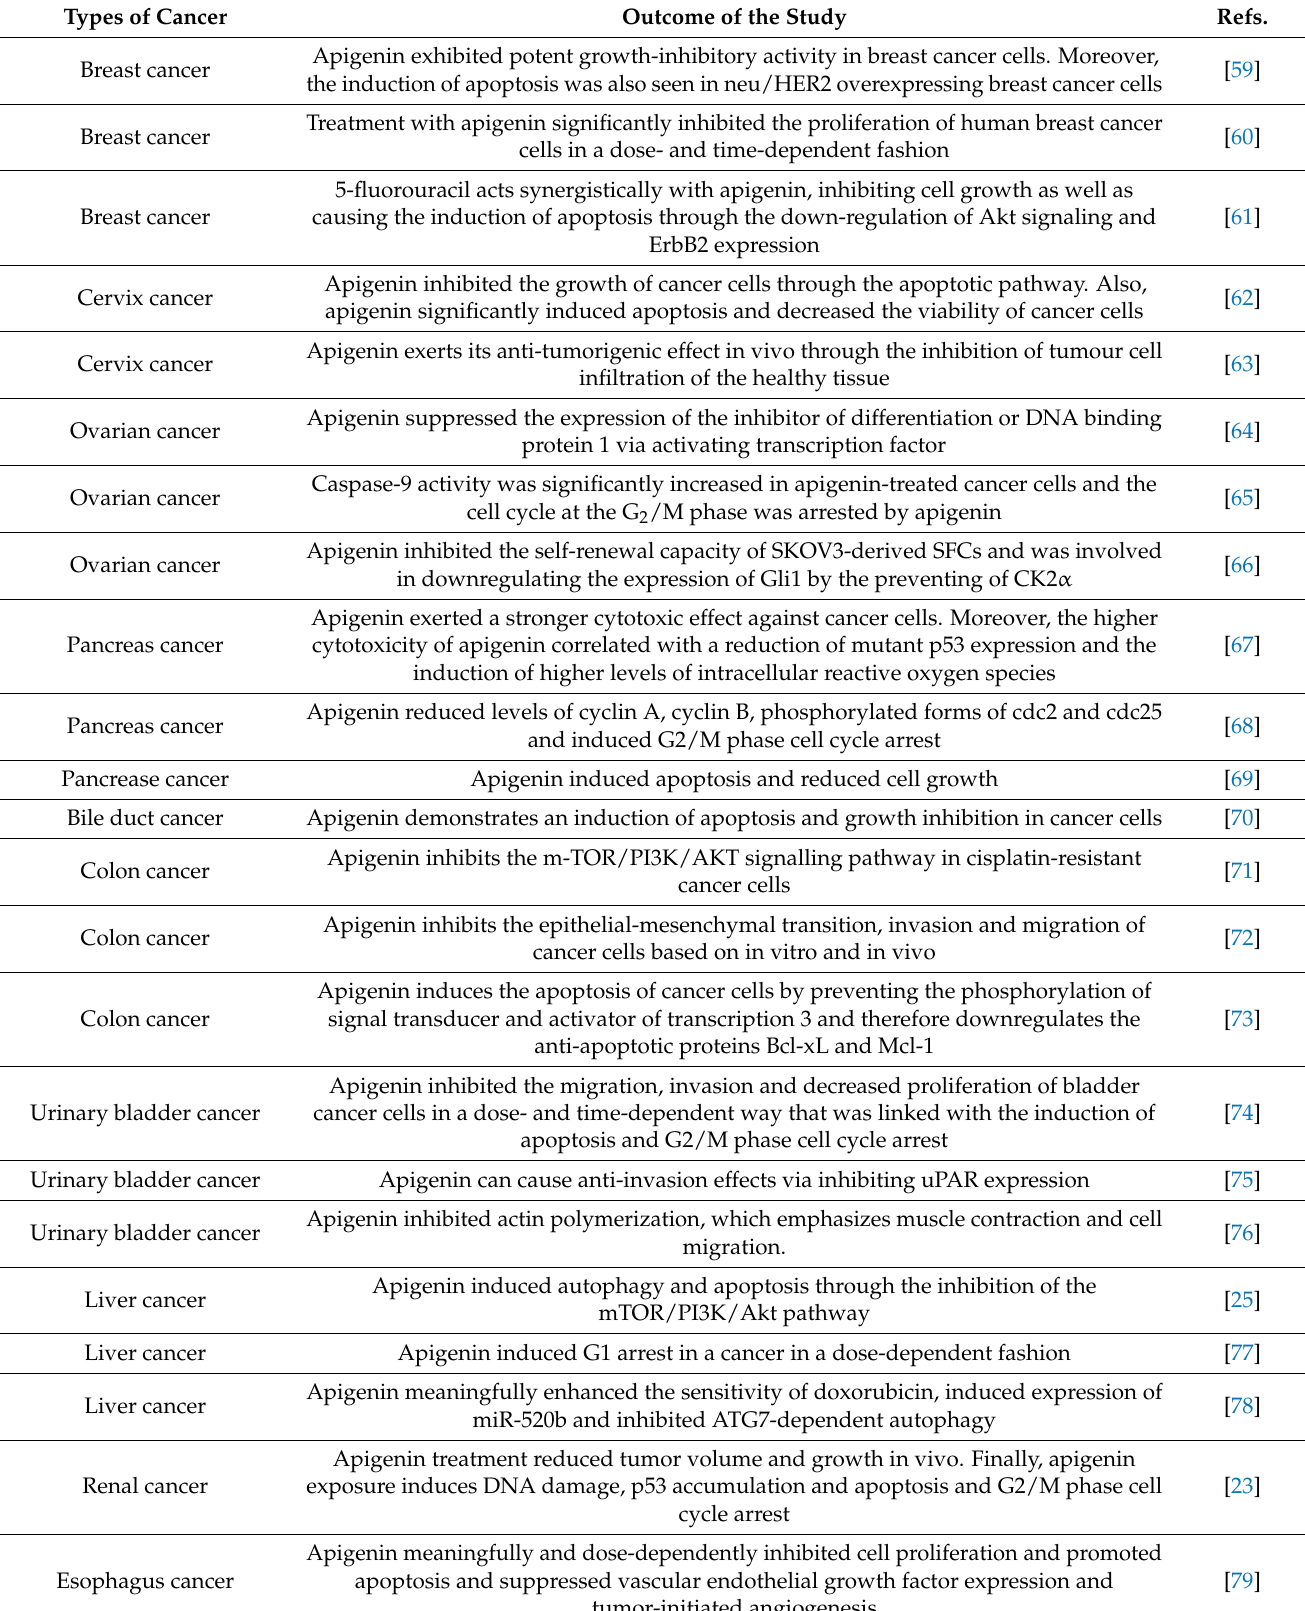
Table 2. Apigenin plays a significant role in various types of cancer inhibition. Outcome of the Study